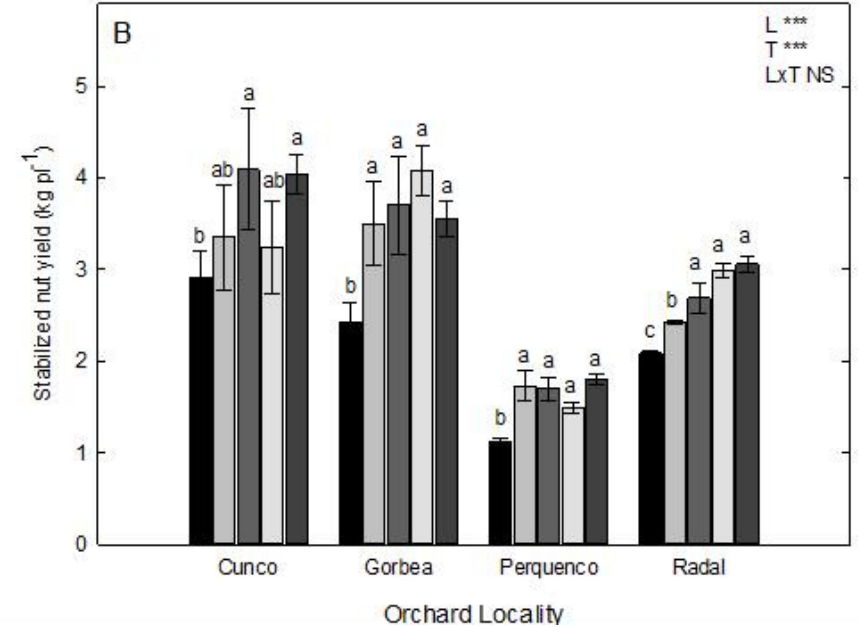
Figure 1. Stabilized nut yield per hectare (kg ha − 1 ) ( A ) and per plant (kg pl − 1 ) ( B ) in TDG hazelnut after the foliar spraying of Ca, Mg and K in four orchard localities in the La Araucanía region. Bars represent the average of four replicates ± S.E. Different letters indicate statistical differences ( p ≤ 0.05) between treatments in the same locality. Two-way ANOVA results are shown; NS: not significant; *** p < 0.001. Control (water), 300+K (Ca+Mg+K at 300 mg L − 1 ), 600+K (Ca+Mg+K at 600 mg L − 1 ), 300 (Ca+Mg at 300 mg L ‒ 1 ), and 600+K (Ca+Mg at 600 mg L ‒ 1 ).